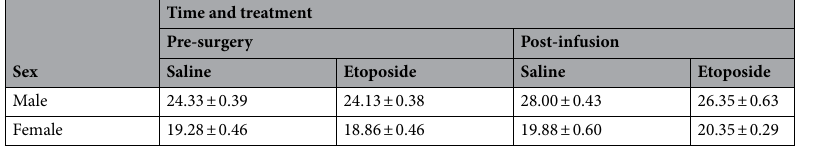
Table 1. Body weights before cannula implantation (“Pre-Surgery”) and at the end of the study (“Post- Infusion”) in male and female mice. Data presented as averages ± SEMs.